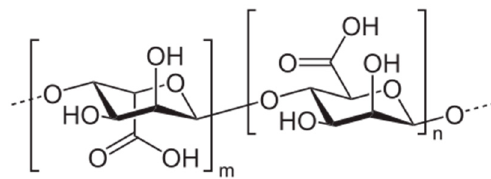
Figure 10. Chemical structure of the guar gum unit.